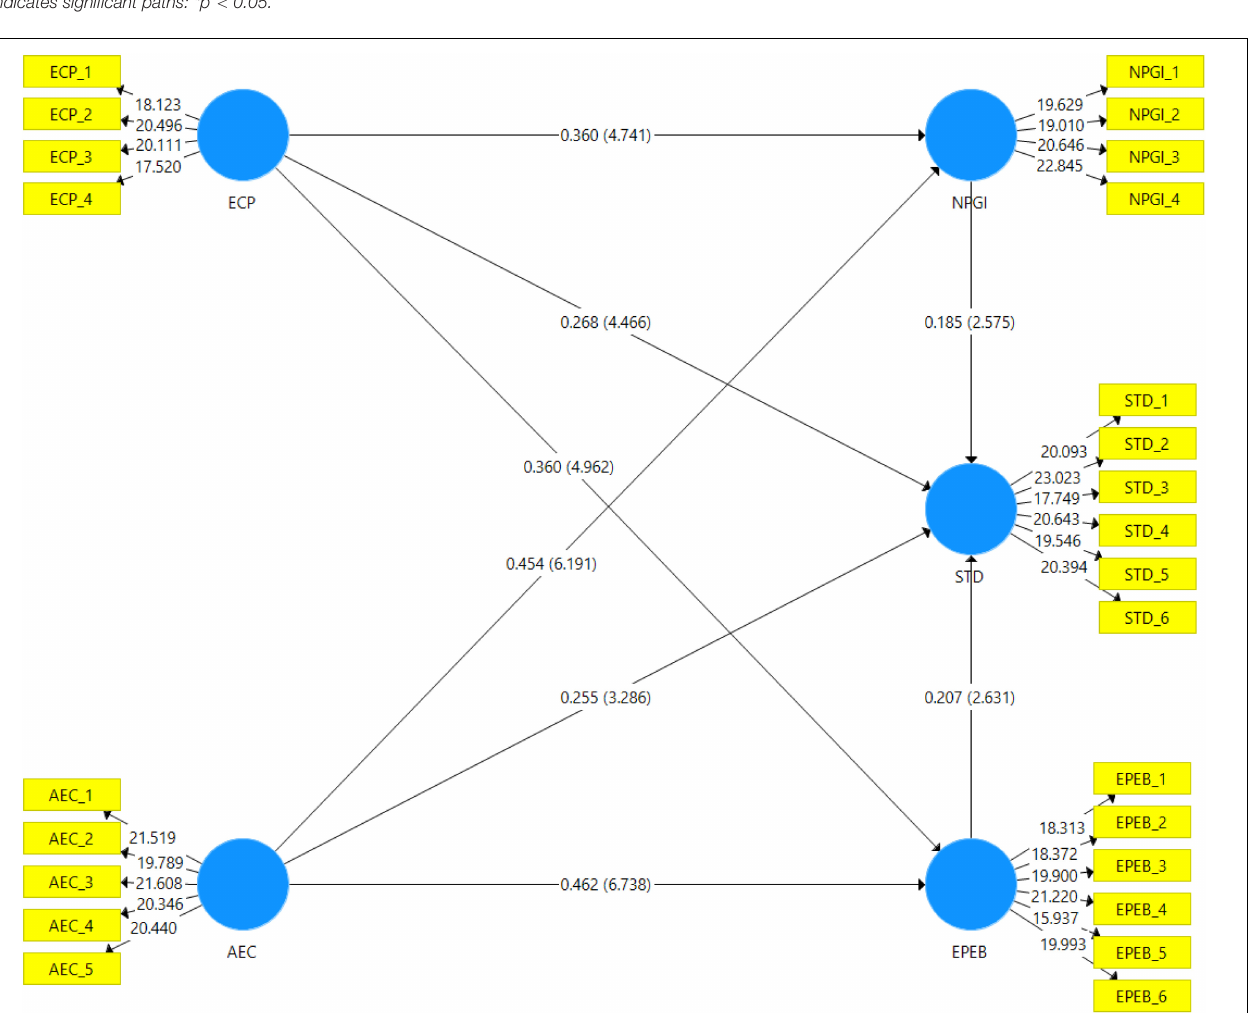
FIGURE 3 | Graphical representation of the structural model.